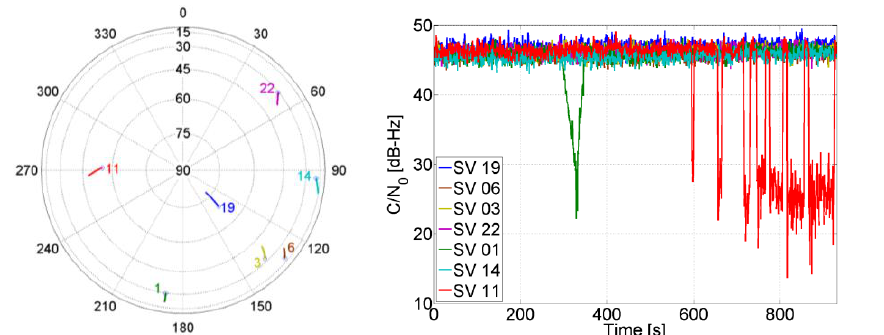
Figure 7. Sky plot during the simulated trajectory ( left ) and received power from satellites ( right ).